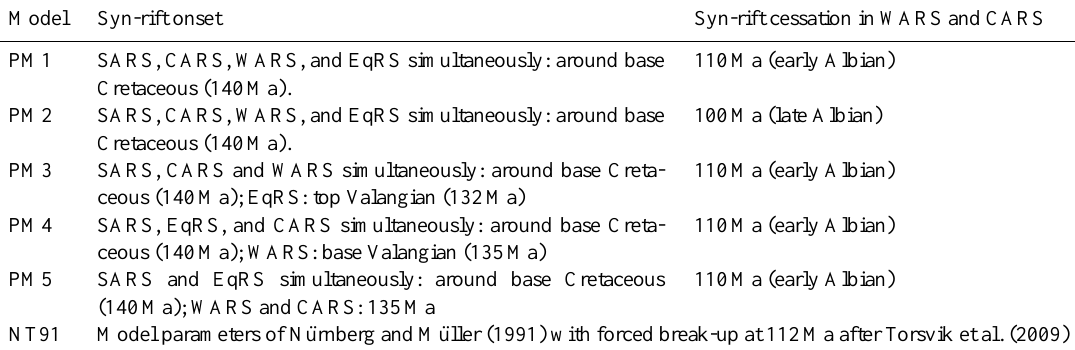
Fig. 9. Visual representation of rotation parameters (Tab.2) as plate circuits used for the plate model for two main stages: (a) 140–120.6Ma and (b) 120.6–110Ma for the main lithospheric plates. Integers indicate the Plate-ID number. Integers on connection lines refer to deforming zones (Table 1). Dashed lines indicate areas where extension is indirectly constrained by plate circuit; connections with dots indicate no relative motion. Plate abbreviations. Table 3. Alternative kinematic scenarios tested for onset and cessation of syn-rift phases in main rift zones. Model Syn-rift cessation in WARS and